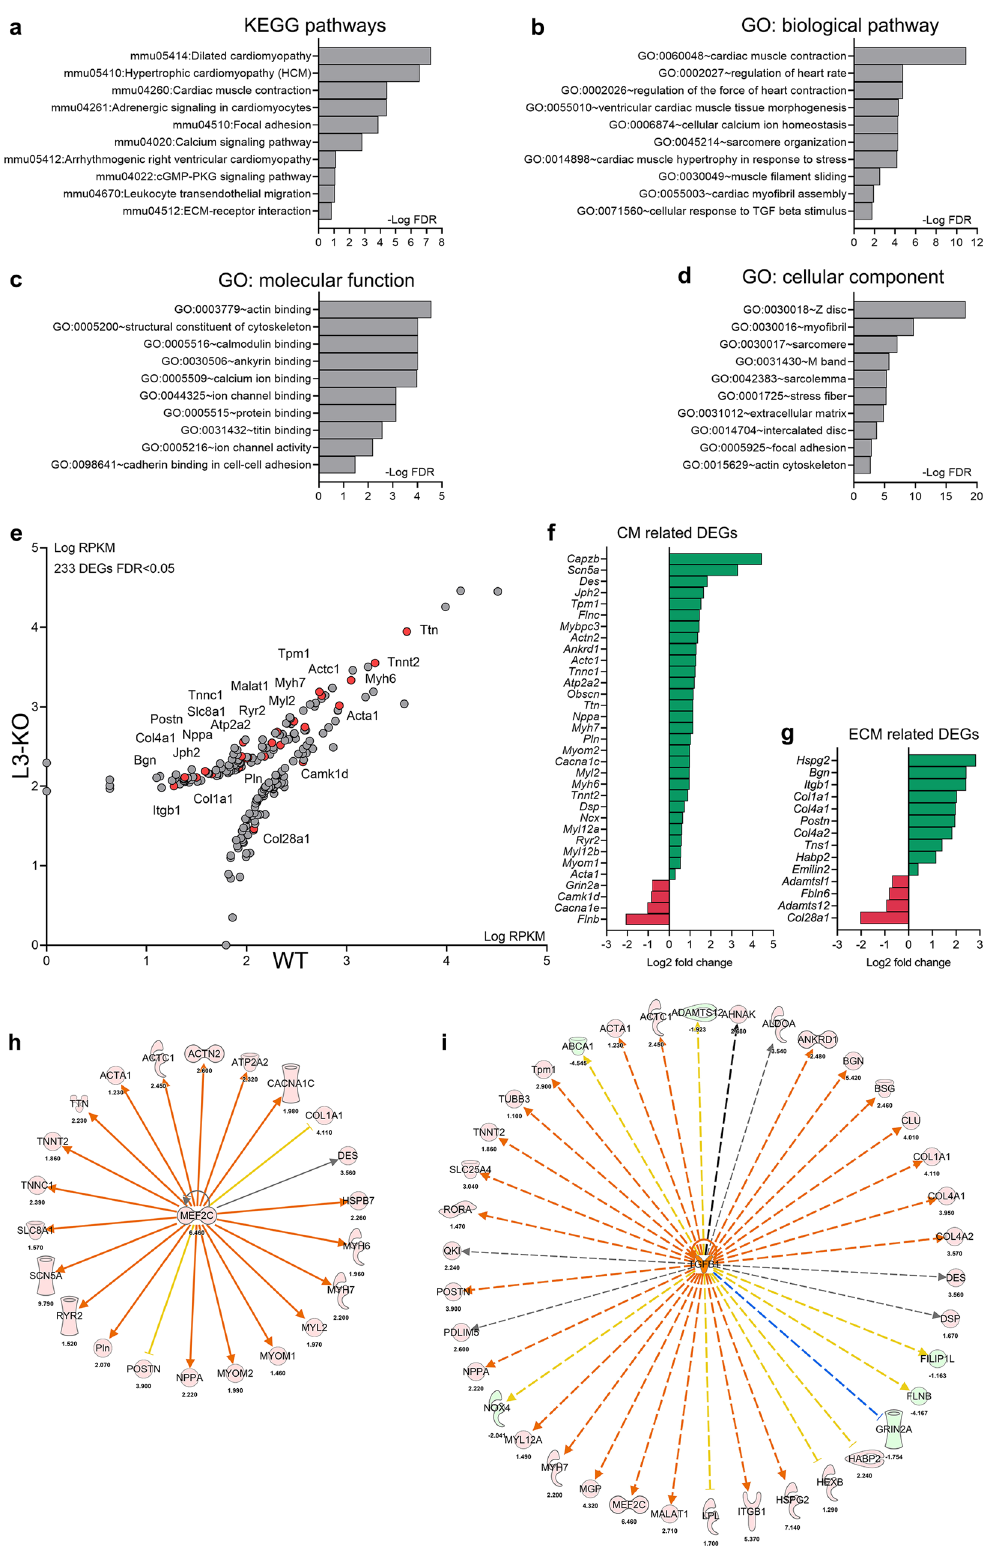
Lysyl oxidase ( Lox) mRNA was increased 1.7-fold in L3-KO compared to WT at six weeks post-AB (Fig. 5c), which could indicate increased collagen crosslinking in the L3-KO. We therefore analysed total, soluble and insoluble collagen content at six weeks post-AB using colorimetric and enzymatic assays on mid-ventricular sections. Importantly, L3-KO LVs had